Question: Which kind of chart has been used to present this data?
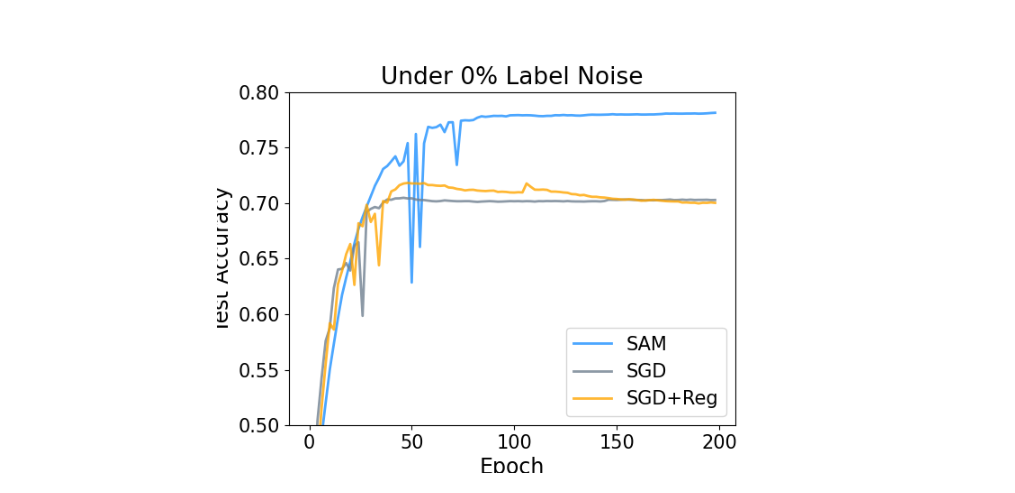
Answer: line